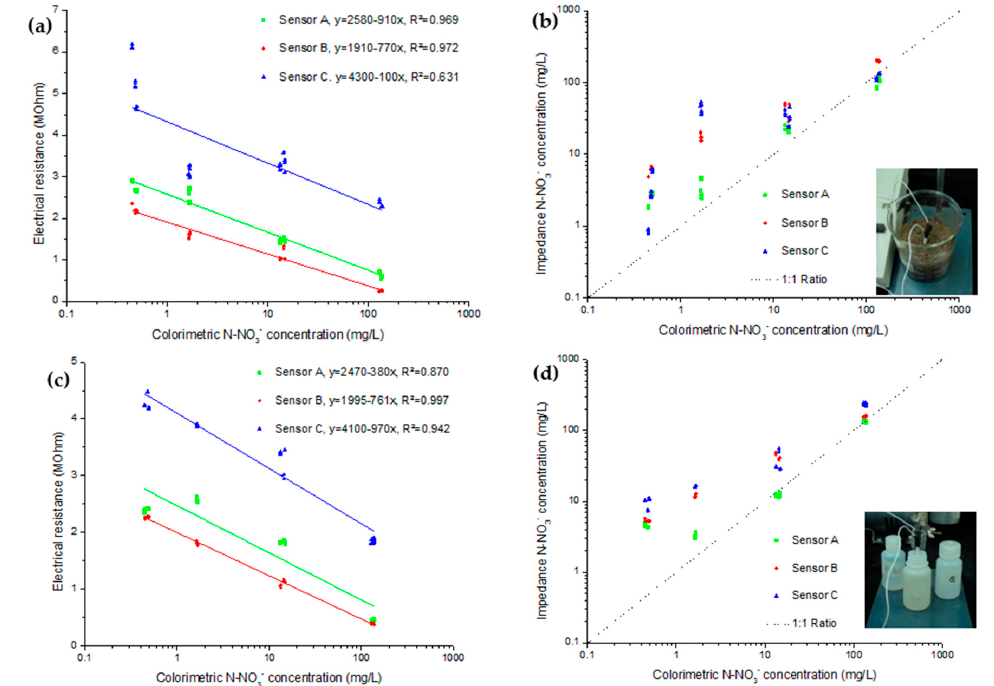
Figure 4. Electrochemical measurement in ( a ) impedance and ( b ) calculated concentration results obtained from saturated potting medium and in ( c ) impedance and ( d ) calculated concentration results obtained from its filtrate. Electrical resistance and calculated concentration are compared to colorimetric measurements of nitrate concentration.